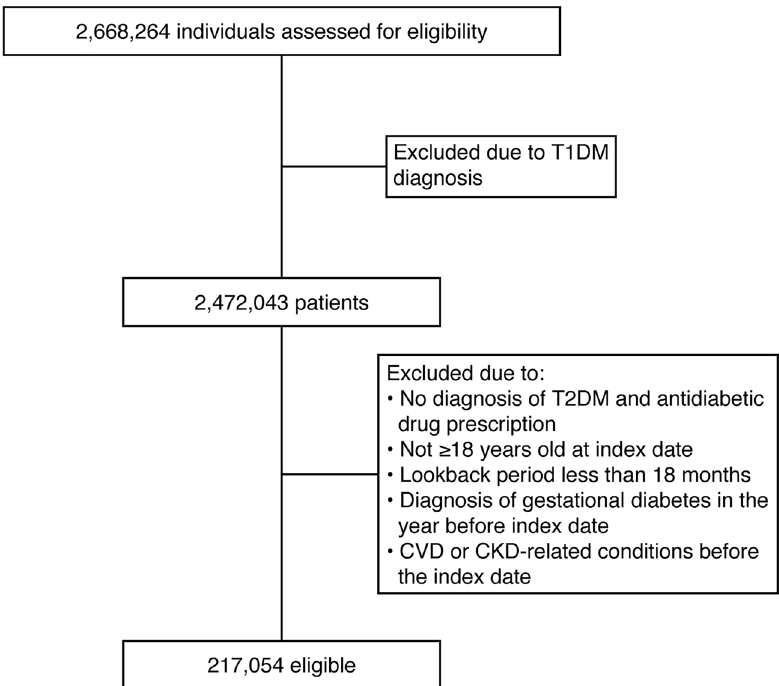
Figure 1. Patient disposition. CKD, chronic kidney disease; CVD, cardiovascular disease; T1DM, type 1 diabetes mellitus; T2DM, type 2 diabetes mellitus.